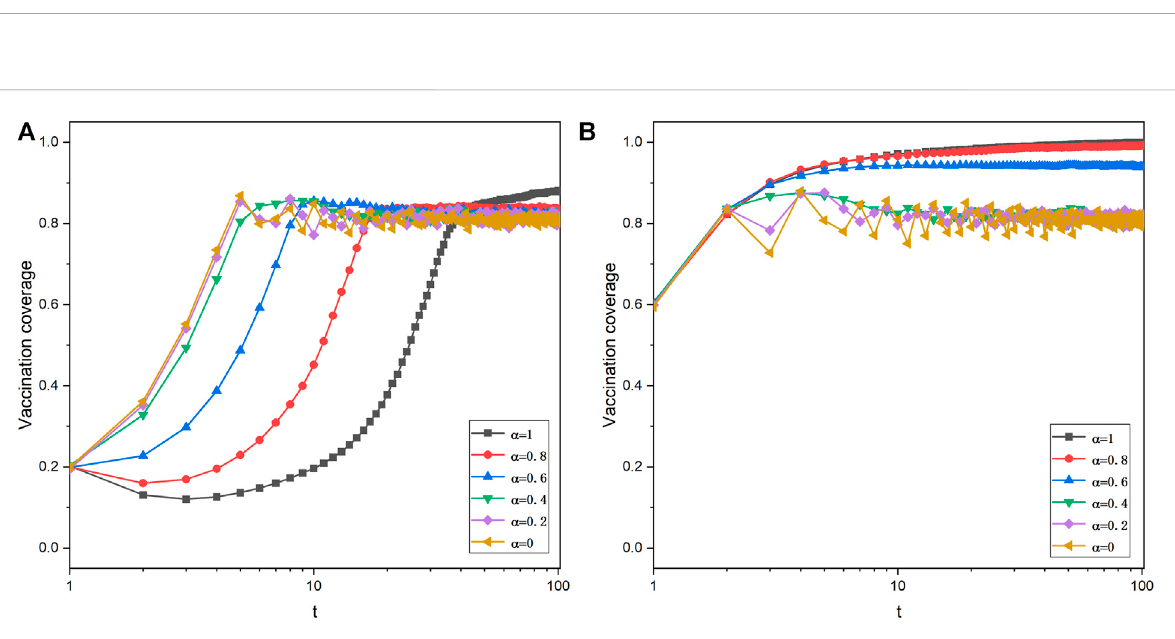
FIGURE 6 TimecoursesofvaccinationcoverageintheWSsmallworldnetwork. V 0 =0.2 (A) and V 0 =0.6 (B) .Depictedresults areobtainedfor γ =0.8, K = 0.1, C V = 0.3, and C H =